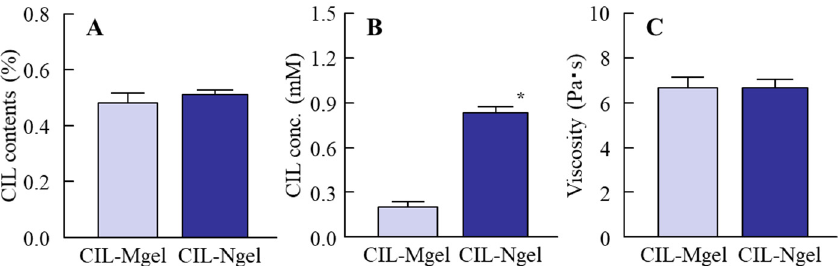
Figure 2. The dispersity ( A ), drug solubility ( B ), and viscosity ( C ) in the CIL-Ngel ( n = 6); * p < 0.05 vs. CIL-Mgel for each category. The CIL particles in both gels were uniform. On the other hand, the dissolved CIL levels in the CIL-Ngel were significantly higher than in the CIL-Mgel.